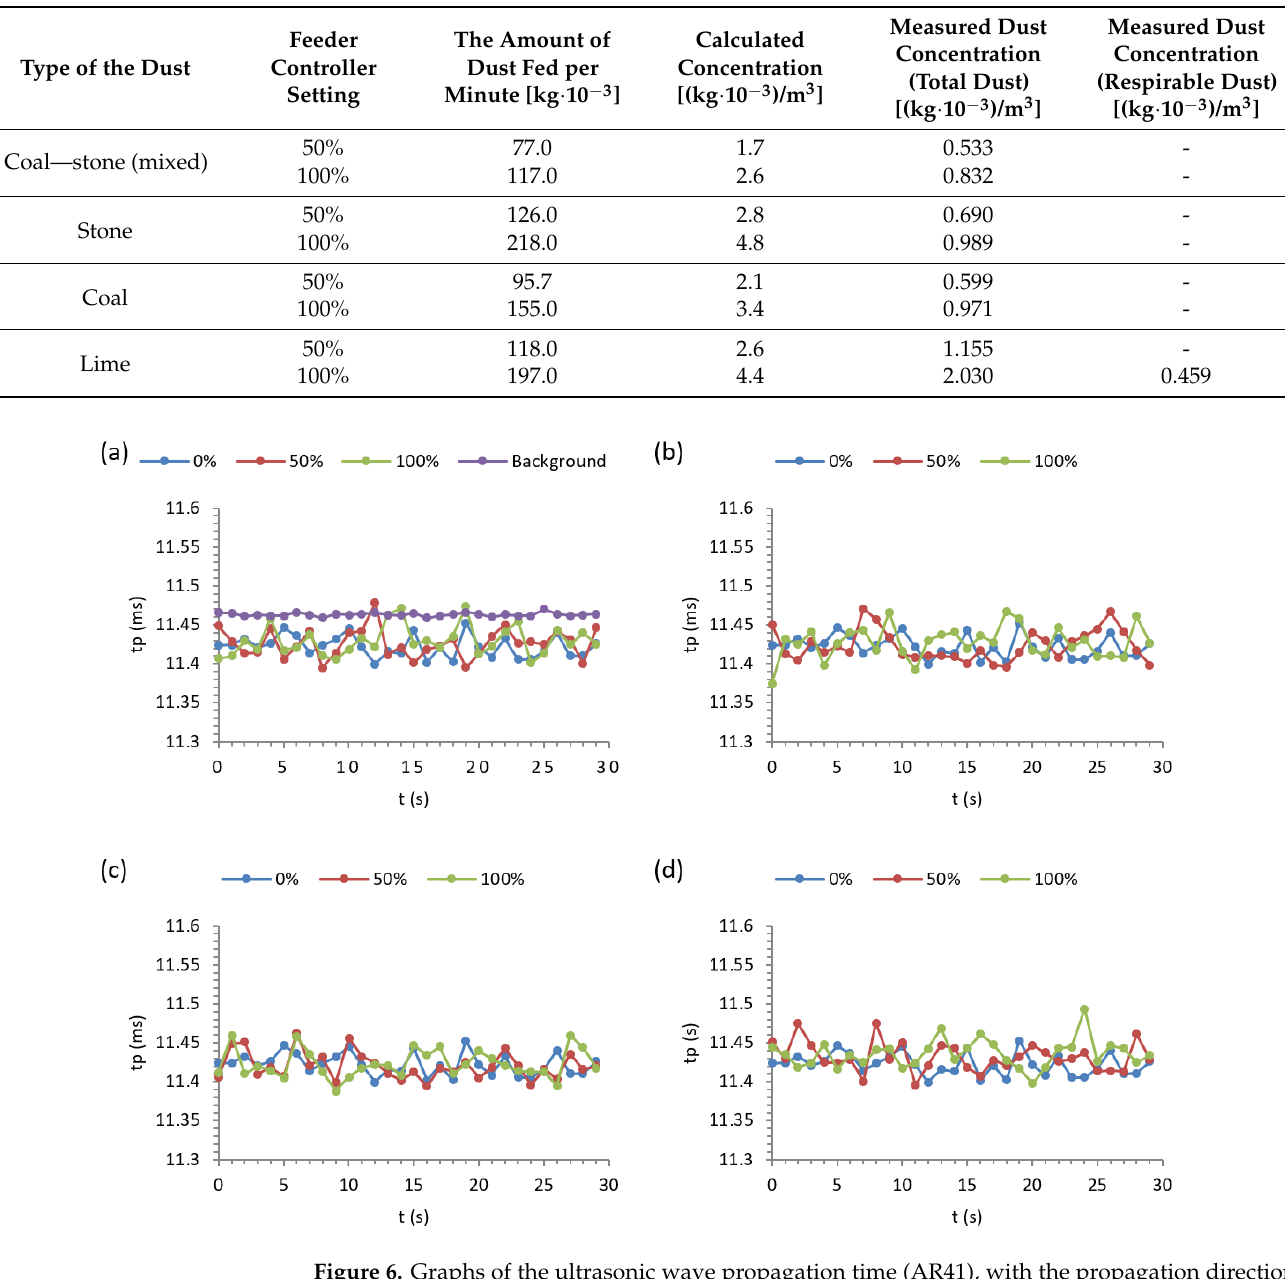
Table 2. Values of dust concentration inside the tunnel during tests with AR41 transducers.